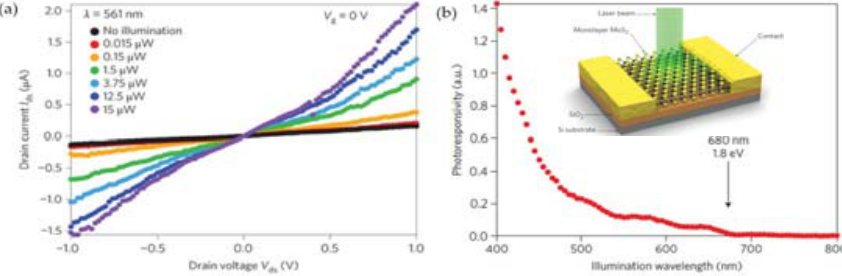
Figure 15. Performance of a monolayer MoS 2 phototransistor. ( a ) I ds –V ds characteristic of the device in the dark and under different illumination intensities. ( b ) Photoresponsivity of a similar monolayer MoS 2 device as a function of illumination wavelength. Inset: Three-dimensional schematic view of the monolayer MoS 2 photodetector and the focused laser beam used to probe the device. Reproduced with permission from [209], Nature Publishing Group, 2013.